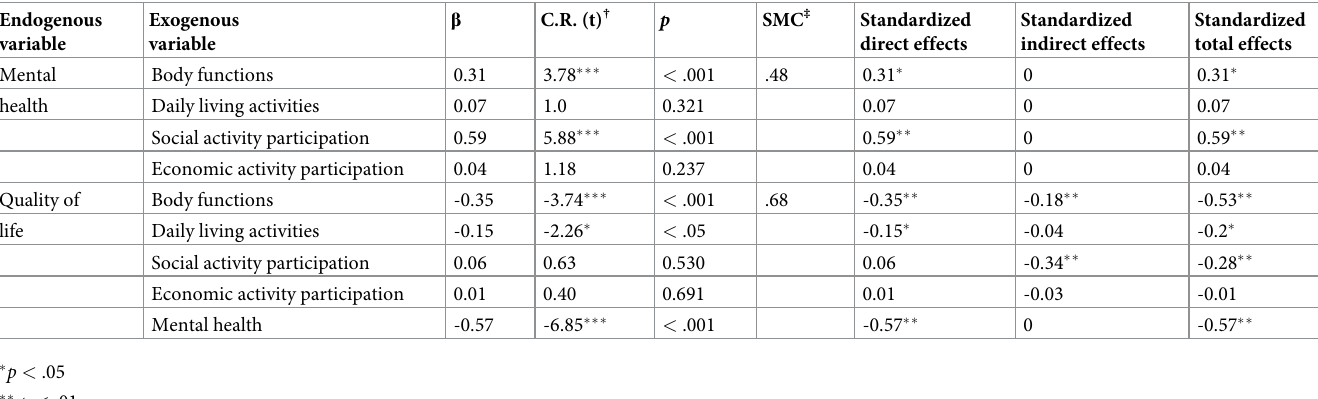
Table 4. Standardized estimates of the modified